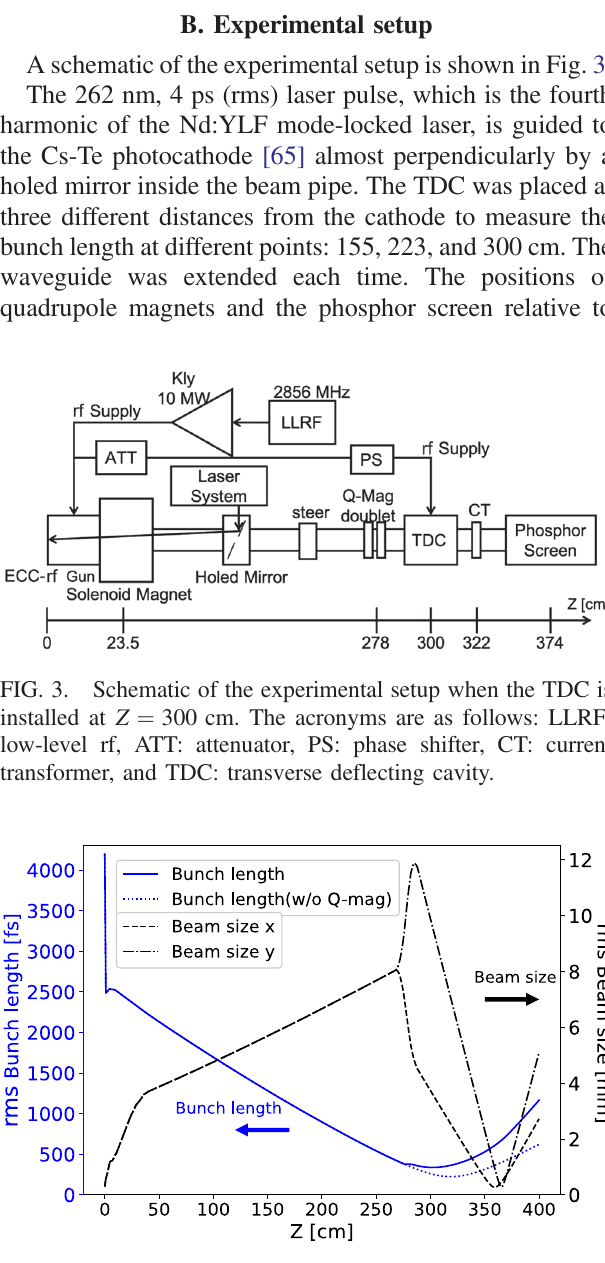
FIG. 6. (a) Example of a nondeflected beam profile. Deflected beam profiles when the TDC is placed at (b) Z ¼ 155 cm, (c) Z ¼ 223 cm, and (d) Z ¼ 300